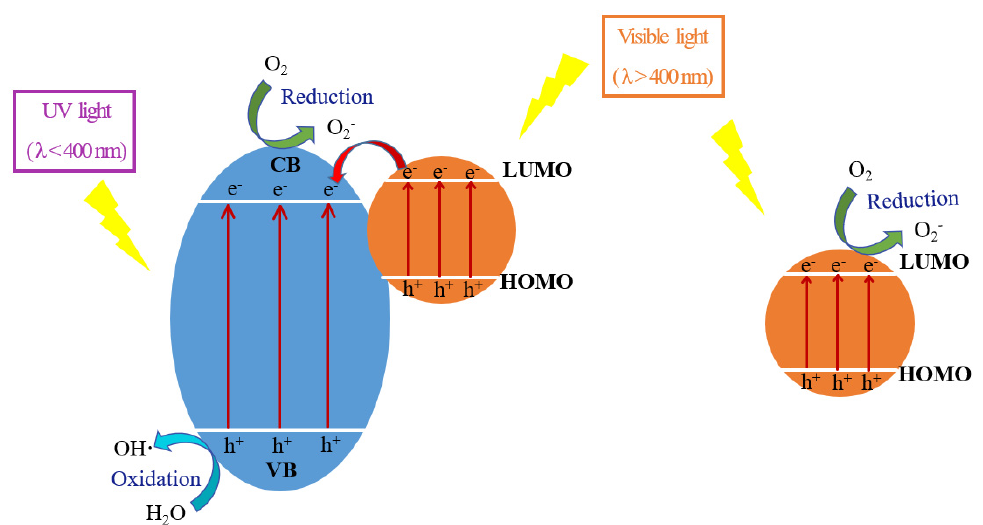
Figure 6. The mechanism of the dye sensitization process.